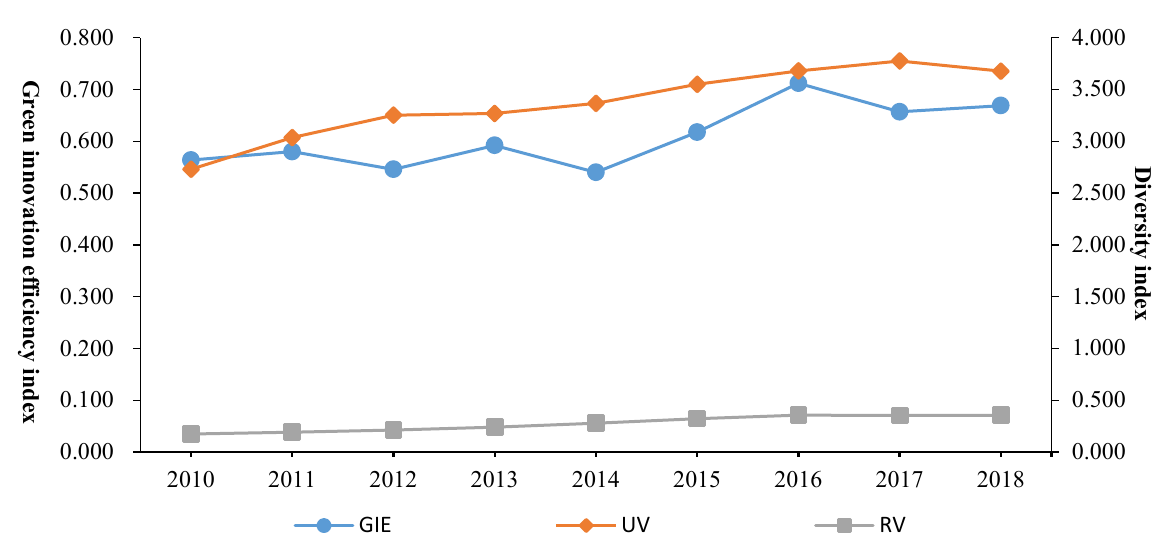
Figure 2. Time series characteristics of green innovation efficiency and related variety and unrelated variety in the Yangtze River Delta from 2010 to 2018.